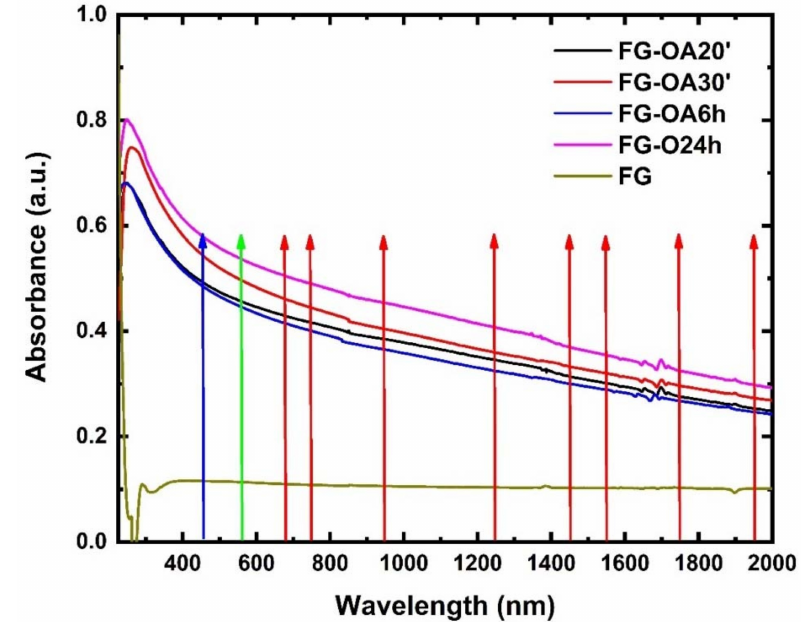
Figure 1. UV-Vis-NIR absorption spectra of pristine FG and the FG-OAx derivatives (all dispersed in